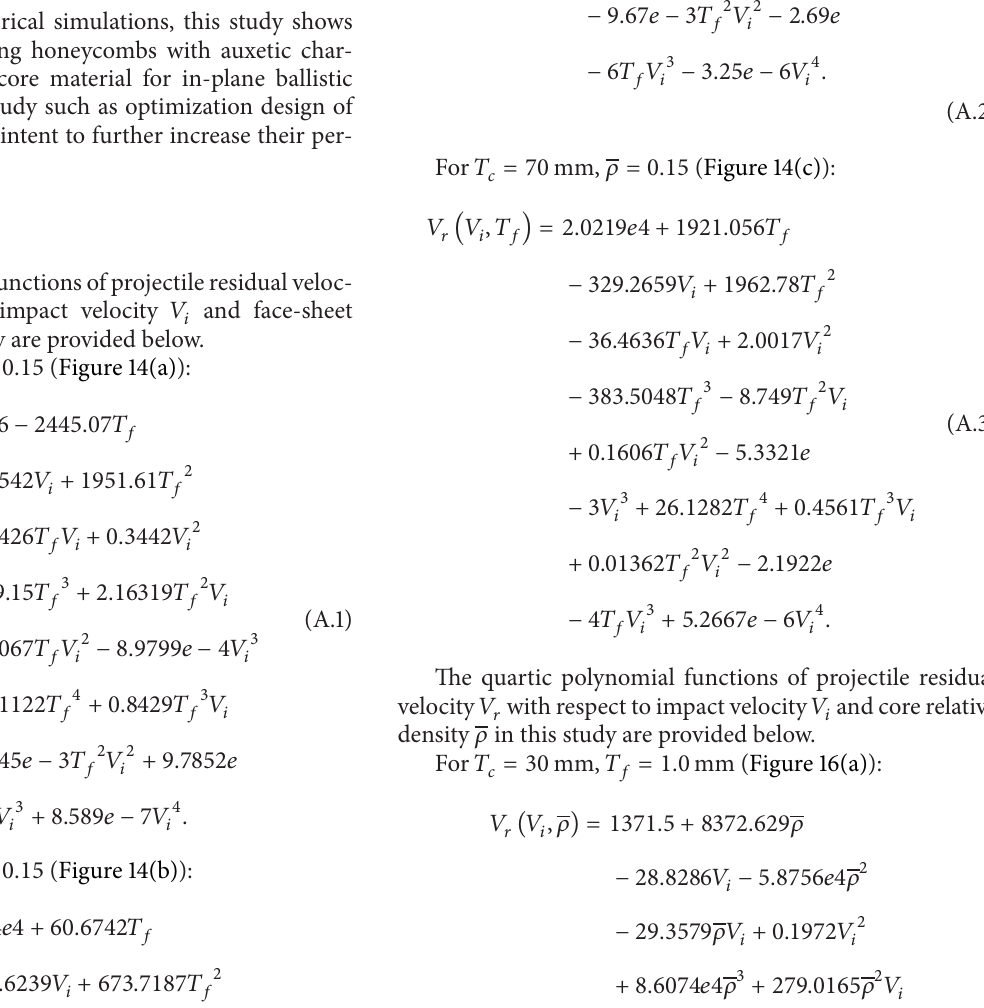
may be used for response